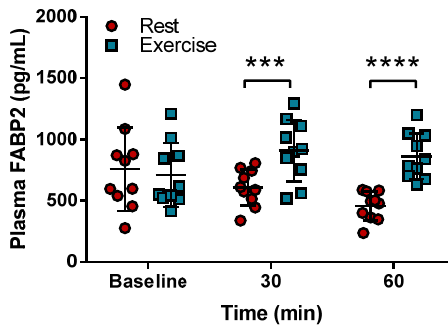
Figure 4. Circulating fatty acid binding protein-2 (FABP2) levels upon exercise. Fatty acid binding protein-2 levels (Mean ± standard deviation) were measured in plasma as a marker of intestinal integrity after 30 min or 60 min during rest (red circles) or exercise (blue squares). *** represents a p -value < 0.001; **** represents a p -value < 0.0001.